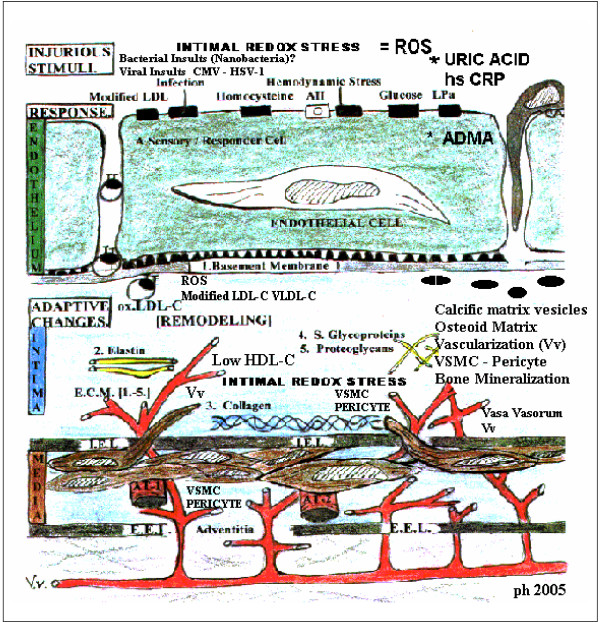
The central role of the endothelium in VOC and atherosclerosis. This image portrays the endothelium as the first line of defense against multiple injurious stimuli. Most of the injurious stimuli are represented by the A-FLIGHT-U toxicities found in table 3. When discussing the role of VOC and how it ties into atherosclerosis and the accelerated ASO associated with metS, prediabetes, and overt T2DM it is important to include the various interactions of A-FLIGHT-U toxicities with the associated ROS and the sensitizers for calcium deposition and ossification (Ca++, Pi, PTH) within the AVW (both the media and intima) in table 5. The role of ROS, inflammation monocyte-macrophage foam cells undergoing apoptosis – necrosis with creation of a nidus and the stimuli for the VSMC and pericyte following the neovascularization (Vv) of the media and intima to result in osteoid formation and later the mineralization within these atherosclerotic plaques. This image also portrays the possible role for nanobacteria in addition to C. pneumonia as well as other bacteria and viral infections as possible contributing factors for the ossification process.